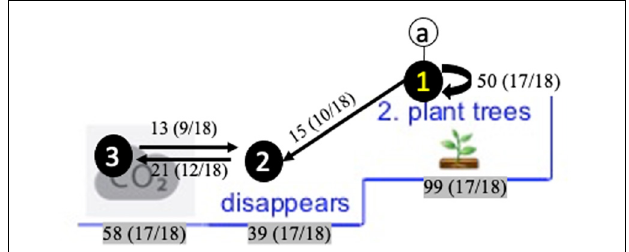
FIGURE 10 | Snapshot of a reading pattern in the blue branch ‘solutions’ to illustrate its’